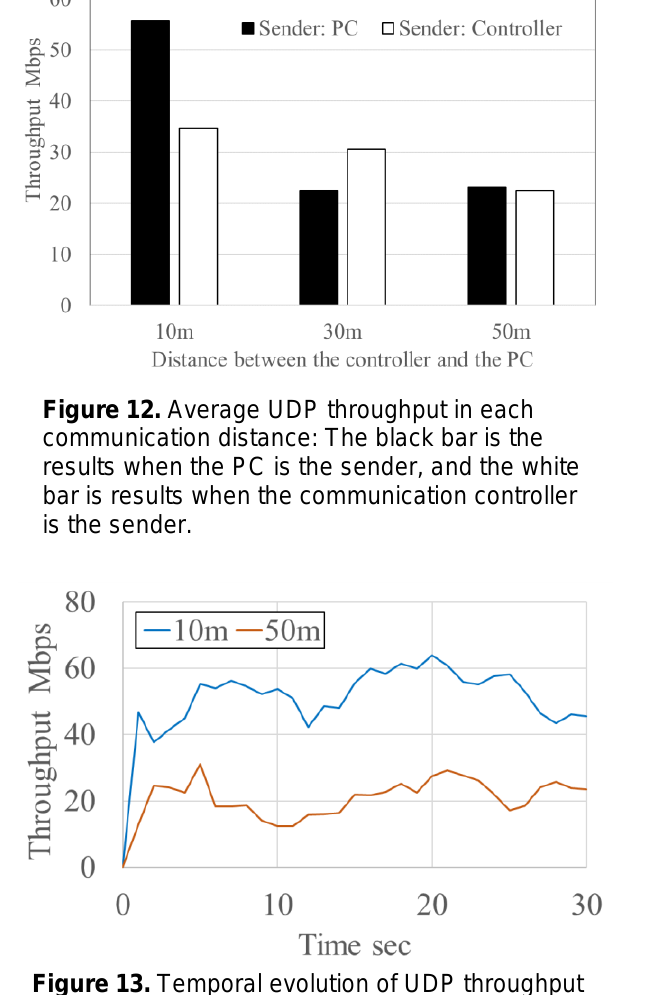
Figure 13. Temporal evolution of UDP throughput in each communication distance (the sender is PC): The blue line is the 10 m results, and the orange line is the 50 m results.